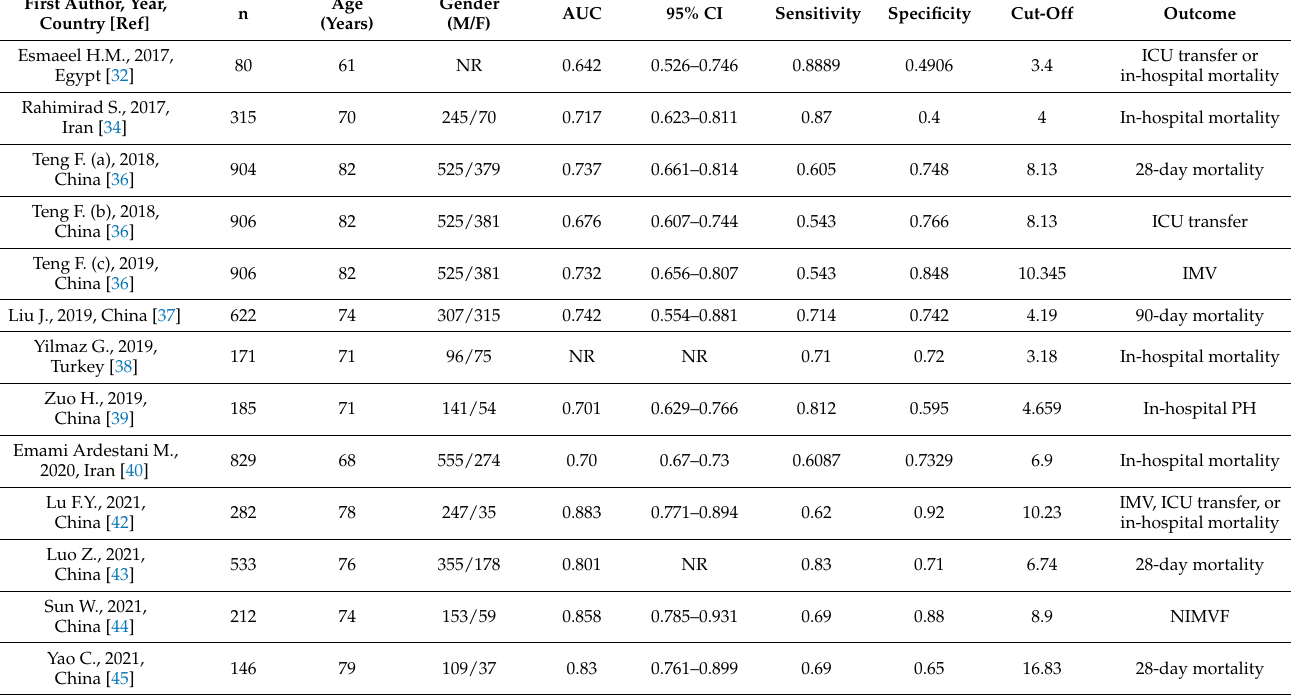
Table 4. Characteristics of studies reporting AUROC, sensitivity, specificity, and cut-off values for the neutrophil-to-lymphocyte ratio to predict adverse